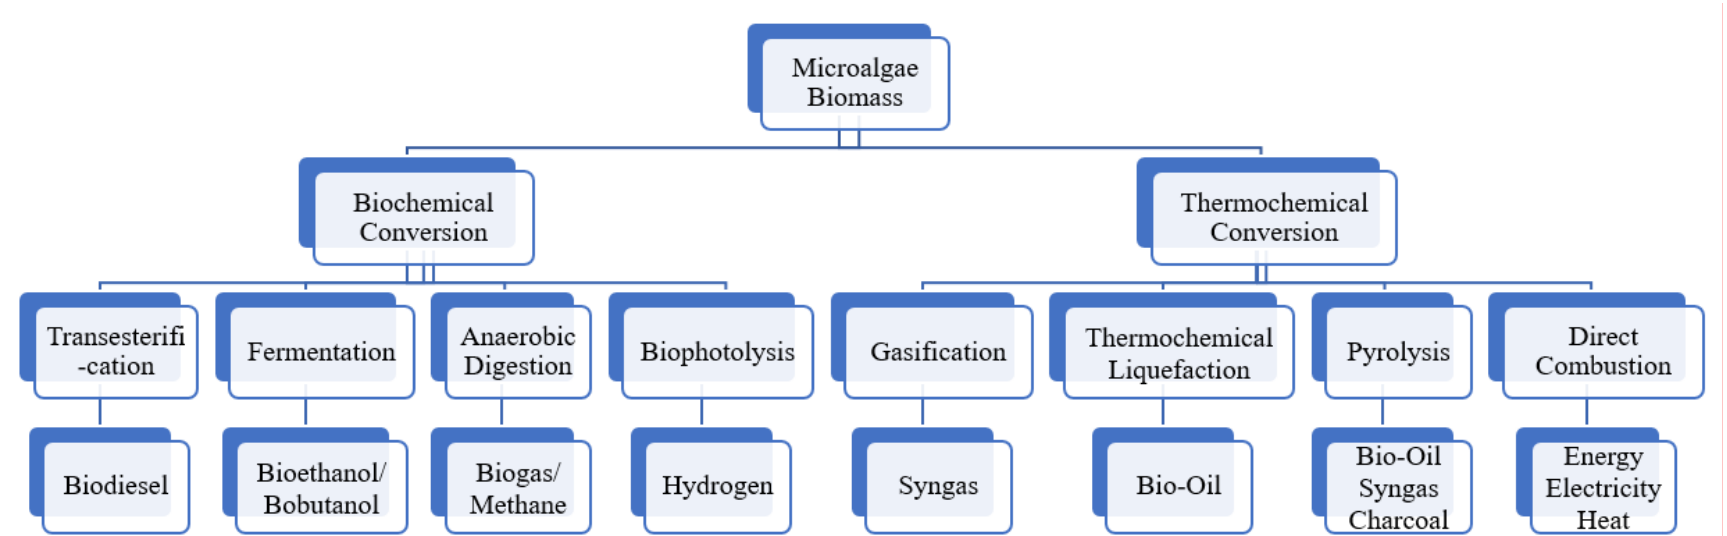
Figure 6. Various methods of producing biofuels/energy from microalgae biomass. Adapted from [16,188].